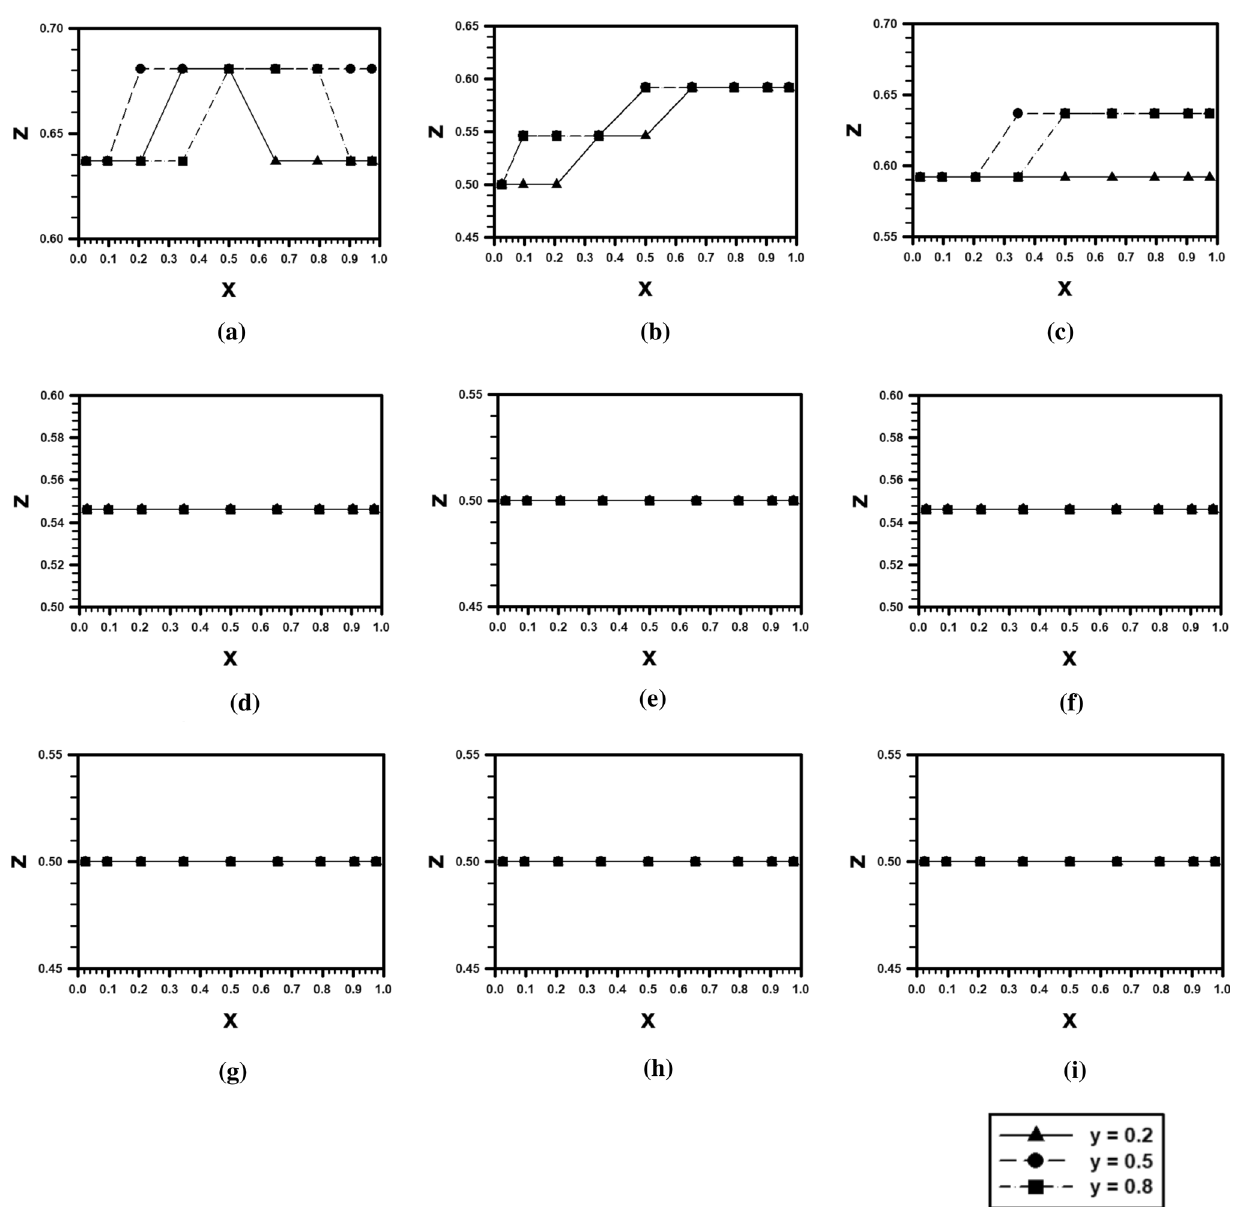
Fig. 13 A sample of the position of the maximum velocities of a longitudinal, b depth and c transverse for velocities of d longitudinal, e depth and f transverse for